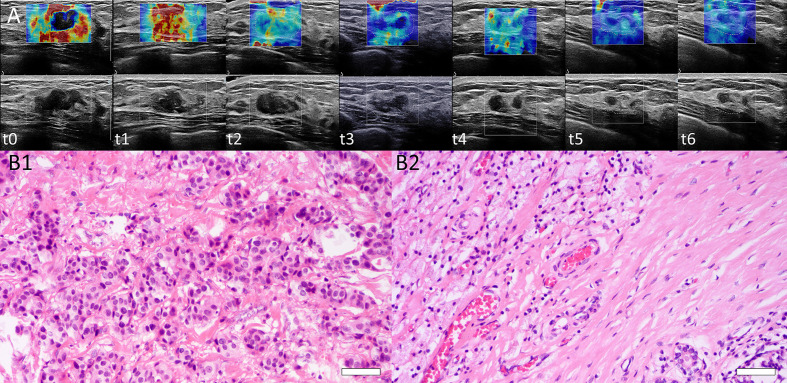

(A) Dynamic SWE changes of a lesion at baseline (t0), interim (t1–t5), and before surgery (t6). Emean and Emax were 70.4 and 168.0 kPa, respectively (t0). Tumor stiffness decreased after each NACT cycle. Emean and Emax were 45.4 and 144.4 kPa (t1), 28.0 and 115.0 kPa (t2), 19.4 and 75.2 kPa (t3), 16.0 and 60.3 kPa (t4), and 12.0 and 50.0 kPa (t5), respectively, and 9.8 and 32 kPa before surgery (t6). (B) Histopathological identification of patient responses by H&E staining. B1: Before NACT, H&E staining of core needle biopsy tissue from one patient was performed, and invasive ductal carcinoma of the breast was confirmed (H&E stain ×200, Bar = 50μm). B2: After surgery, the surgical specimen of this patient showed a complete histological response with no residual tumor cells remaining (H&E stain ×200, Bar = 50μm). This was a pCR with RCB = 0.